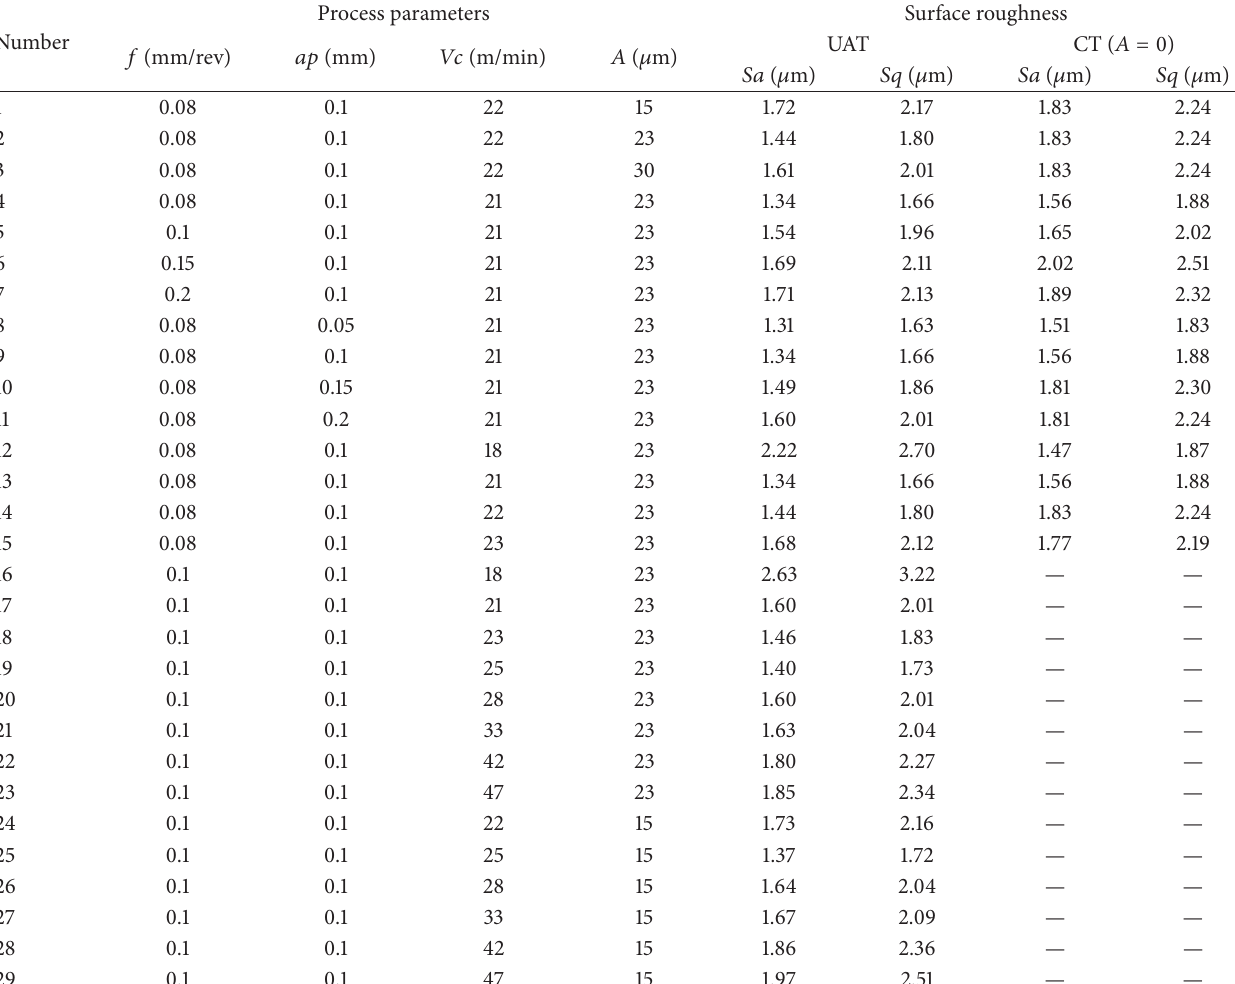
Table 5: Surface roughness in UAT and CT used for experimental